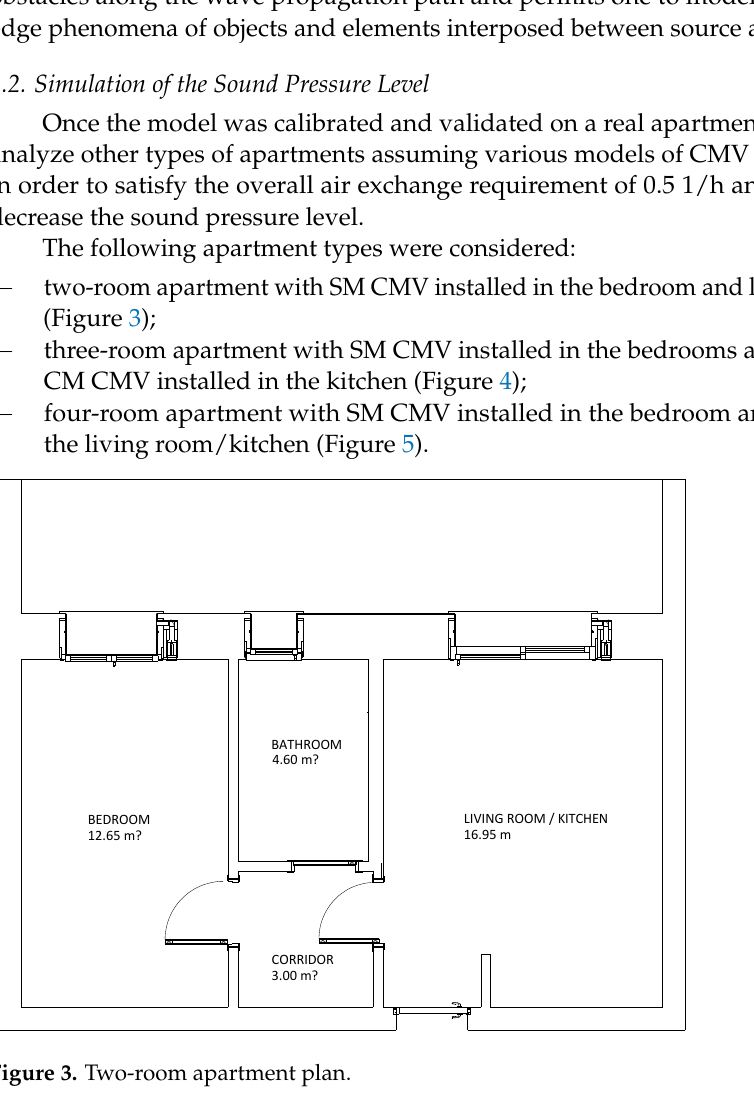
Figure 3. Two-room apartment plan.